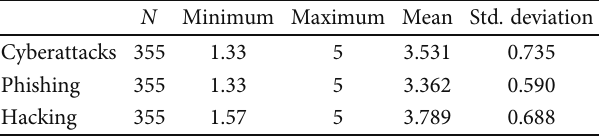
Table 2: Descriptive statistics of the